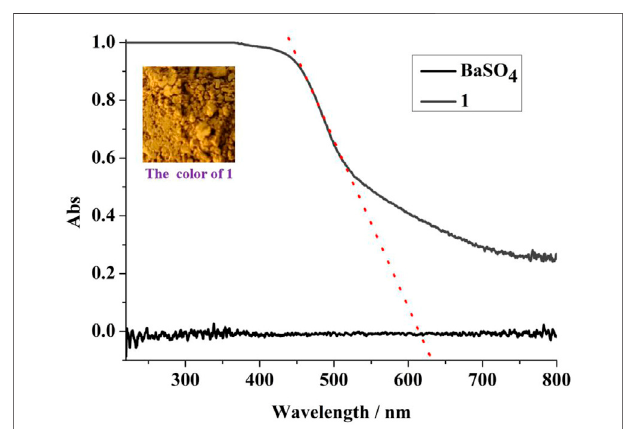
FIGURE 4 | The UV-Vis absorption spectroscopy of 1